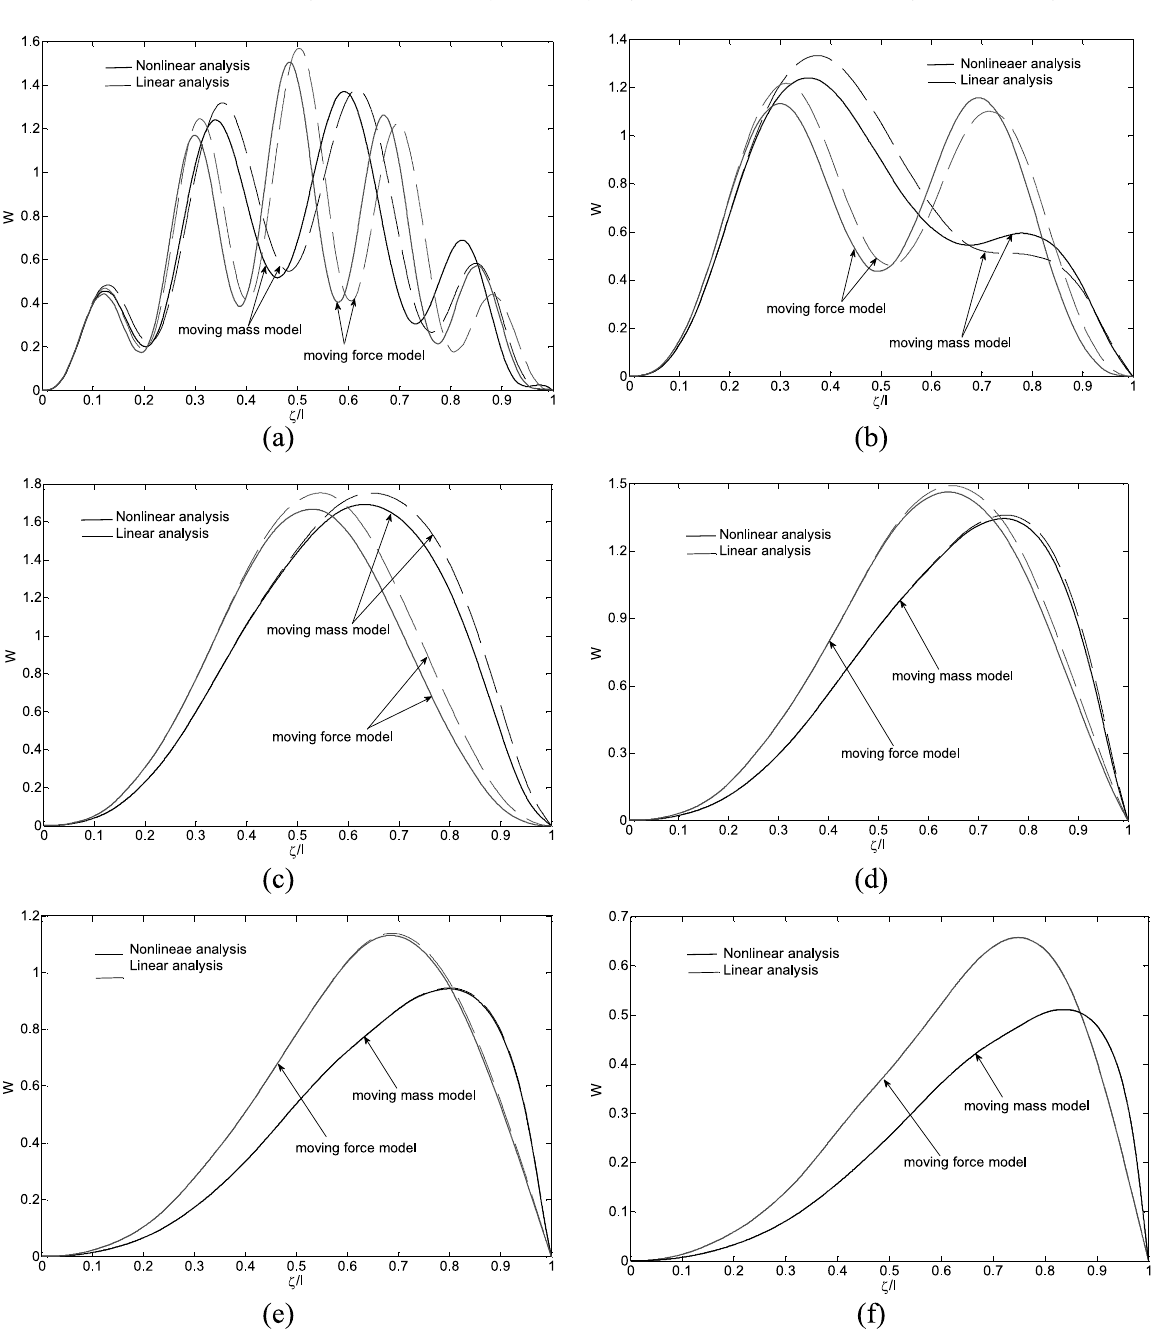
Fig. 9. Normalized vertical de fl ection ( W = w d / w st ) vs. ζ ( t )/ l under a moving load, θ = 36 ◦ ; (a) α = 0.1, (b) α = 0.25, (c) α = 0.5, (d) α = 0.75, (e) α = 1, (f) α = 1.5. (—–) nonlinear analysis, ( ) linear